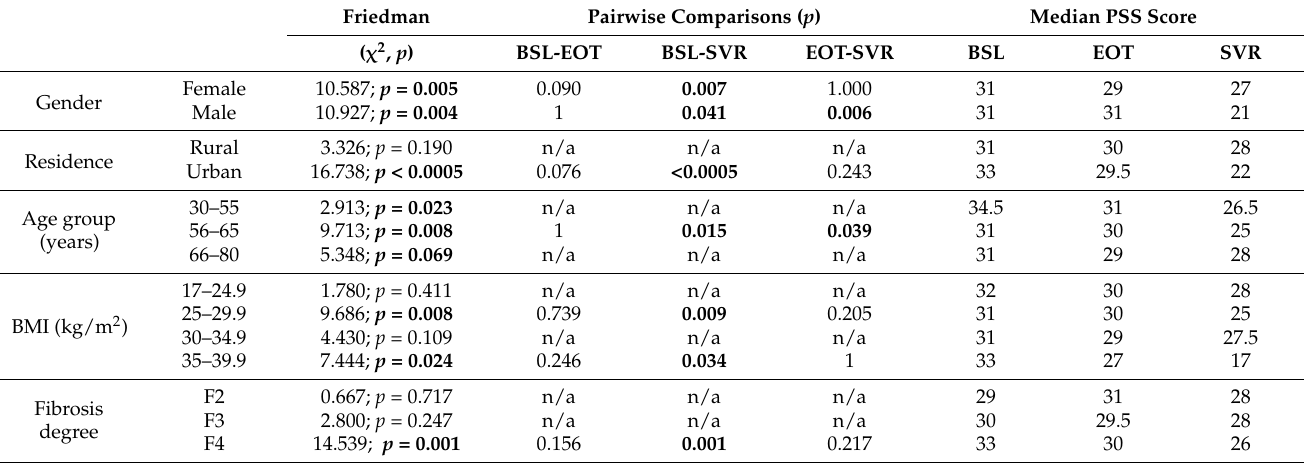
Table 5. Statistical analysis of the study data (Friedman test, pairwise comparisons, median